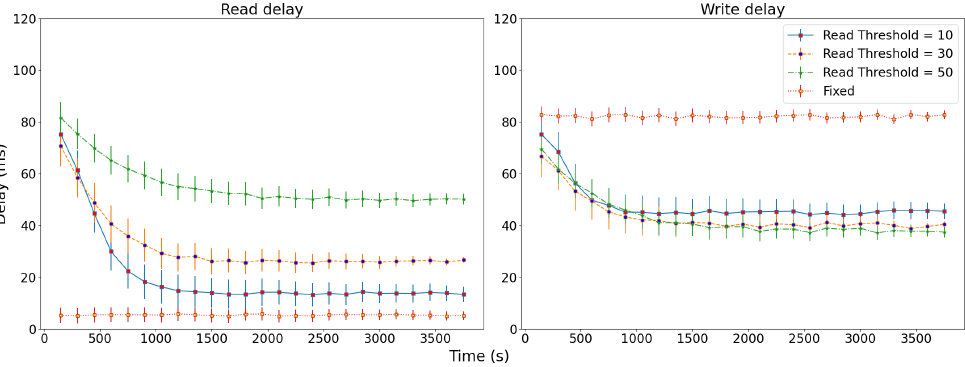
Figure 9. ReadDelay and WriteDelay with different values of ThR .